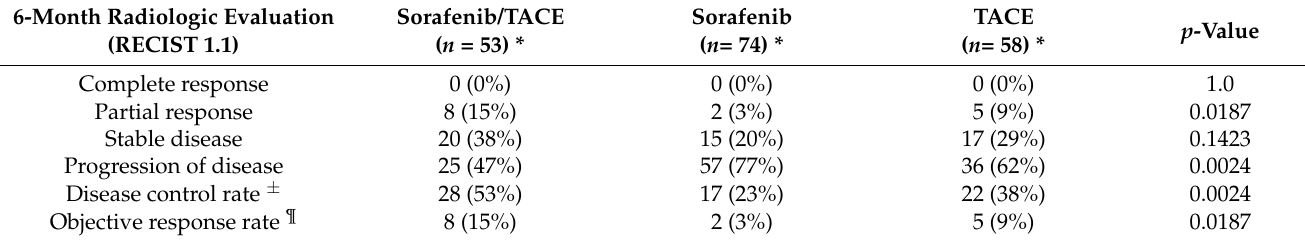
Table 2. Summary of outcomes according to RECIST 1.1 evaluation after 6 months.